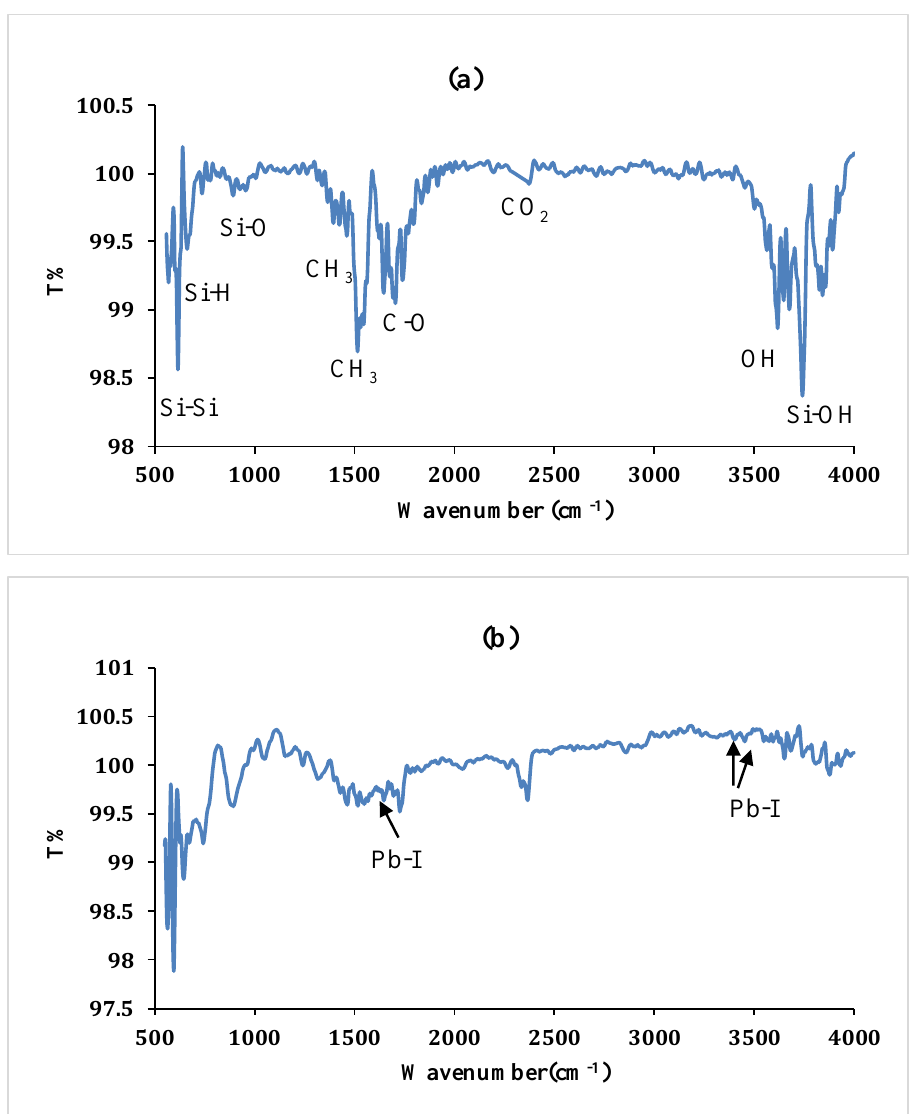
Figure10 : FTIR spectra (a): n-PSi layer and (b) PbI 2 /PSi